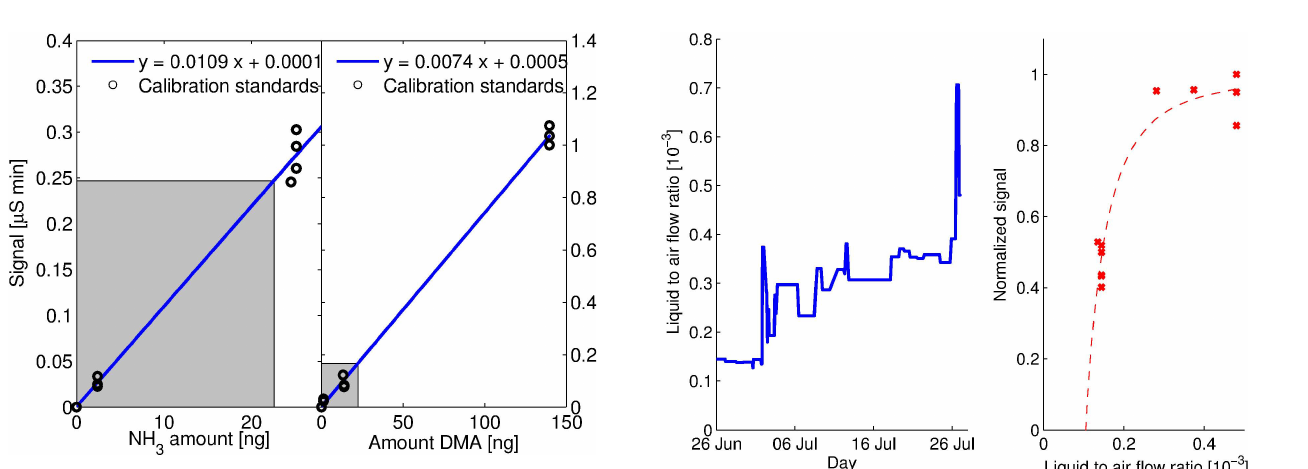
Fig. 4. Liquid to air flow ratio from the sampling line used dur- ing the campaign (left panel). Normalised signal varying the liq- uid to air flow ratio while sampling a constant DMA concentra- tion (around 100pptv) in the chamber (right panel) with fit curve ( y = ax b + c